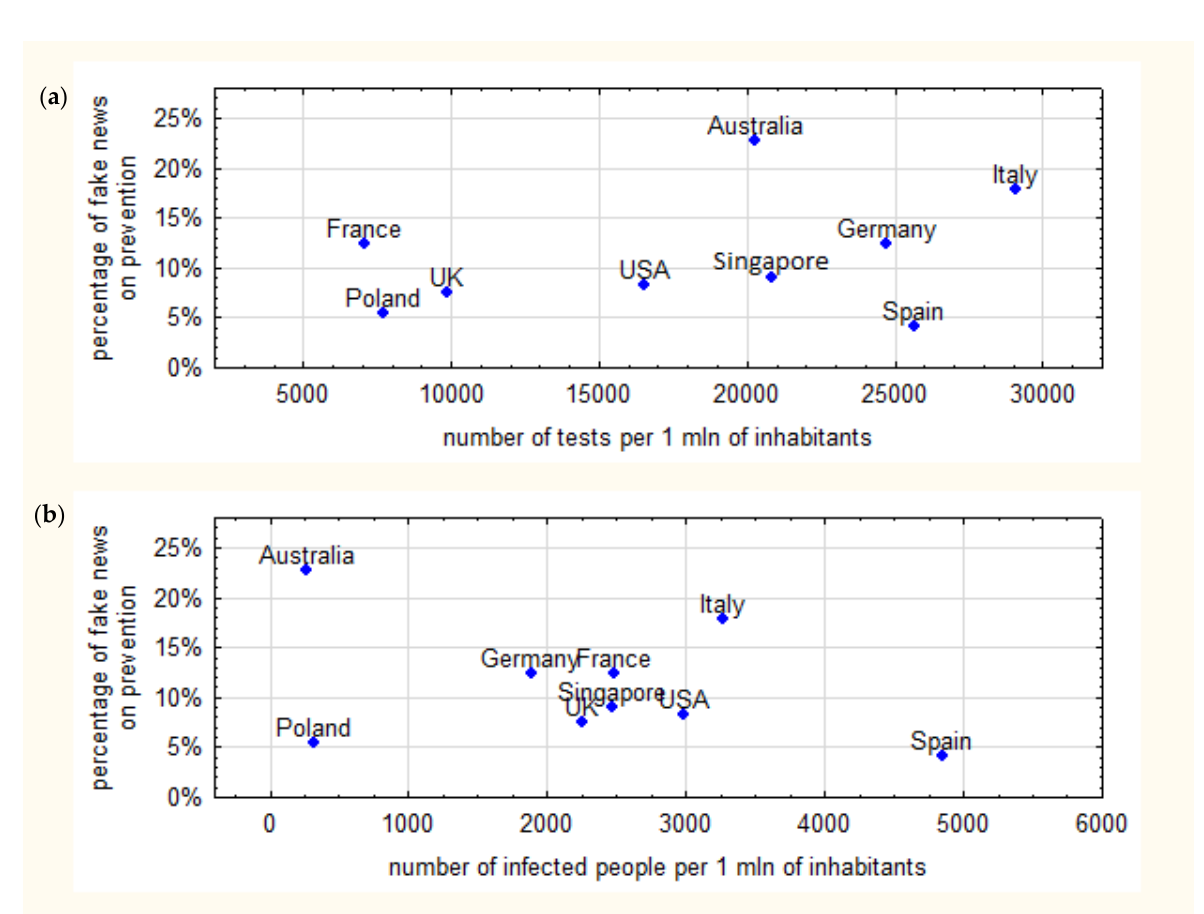
Figure 5. ( a , b ) Scatter plots of ( a ) number of tests and percentage of fake news on prevention and ( b ) number of infected people and percentage of fake news on prevention.